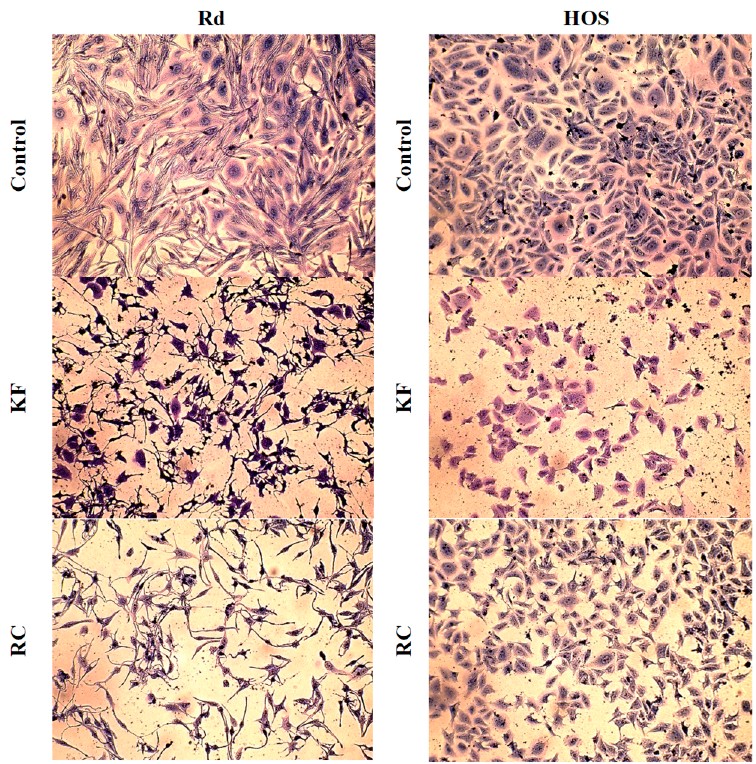
Figure 5. Morphological changes appeared under an ordinary inverted light microscope after staining the cells of the Rd and HOS lines with Giemsa and after exposure to 72 h of incubation with red clover and kudzu flower extracts in a concentration of 64 µ g/mL. Images were captured at original magnification, ×100.